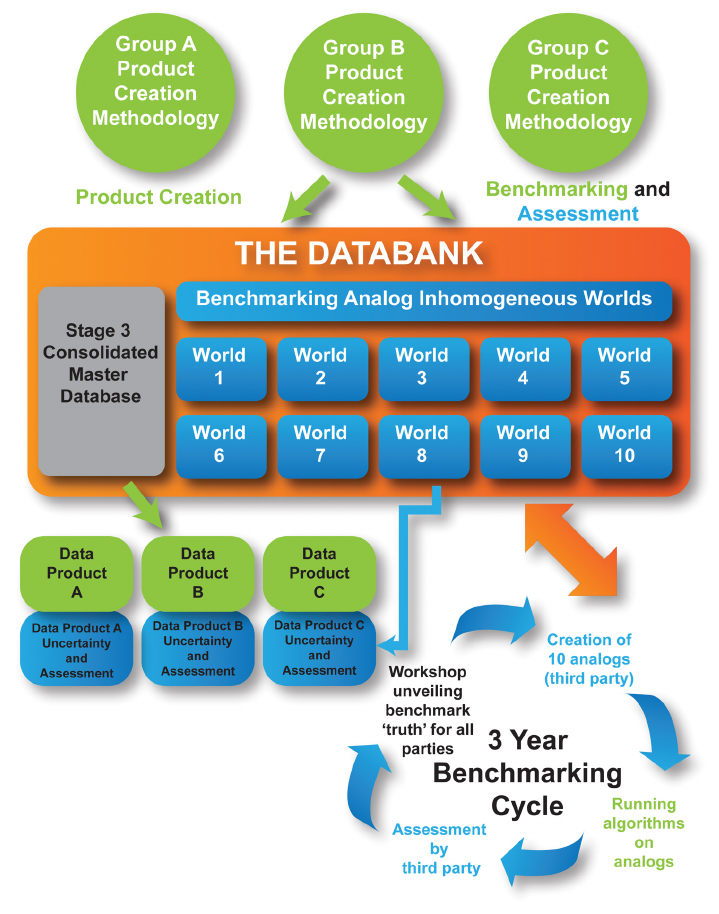
Figure 3. Schematic of the benchmarking assessment and benchmark cycle (source: Fig. 3 in Thorne et al.,